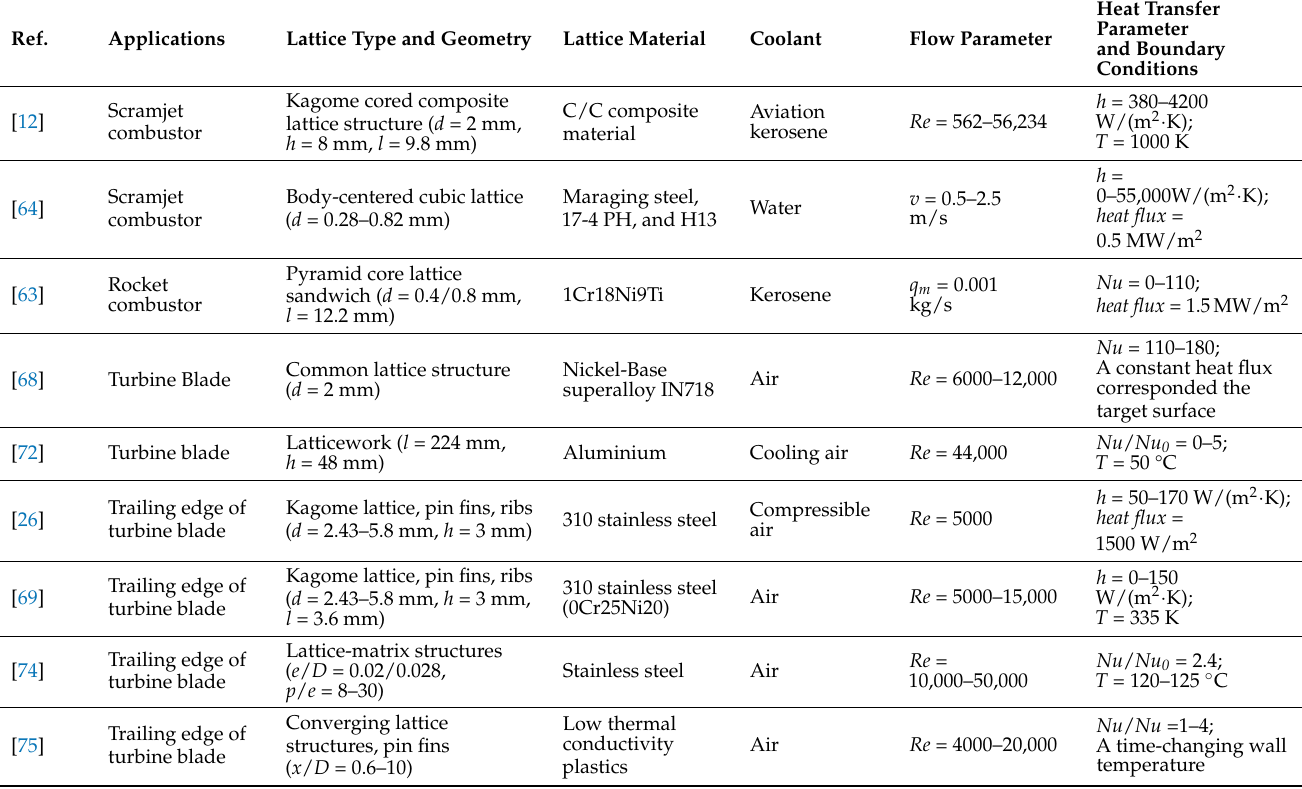
Table 1. Literature on different applications of porous/lattice structures in aerospace field.